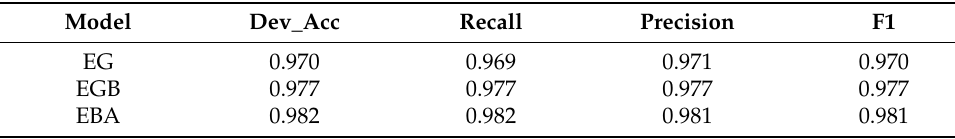
Table 4. Ablation experiment of EBA